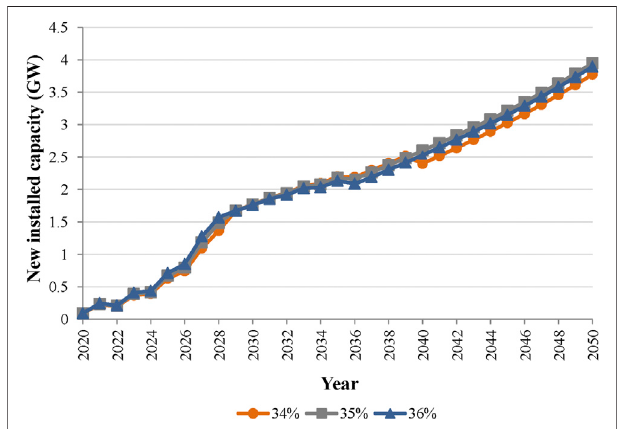
FIGURE10| Cumulativeinstalledcapacityunderdifferentcarbonpermit prices.